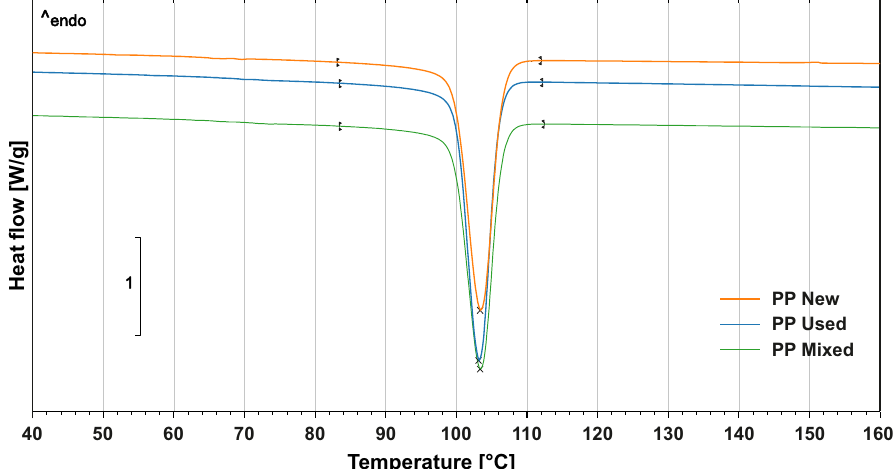
Figure 3. Crystallinity point of (new, used, mixed) PP powders.